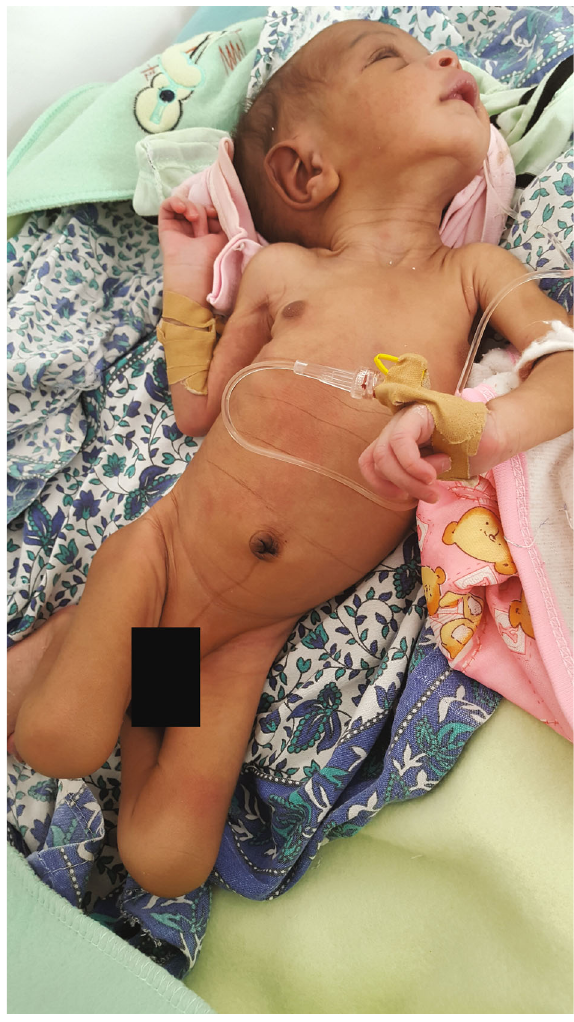
Figure 1: Picture of a 12 -day neonate on admission with hyperextended